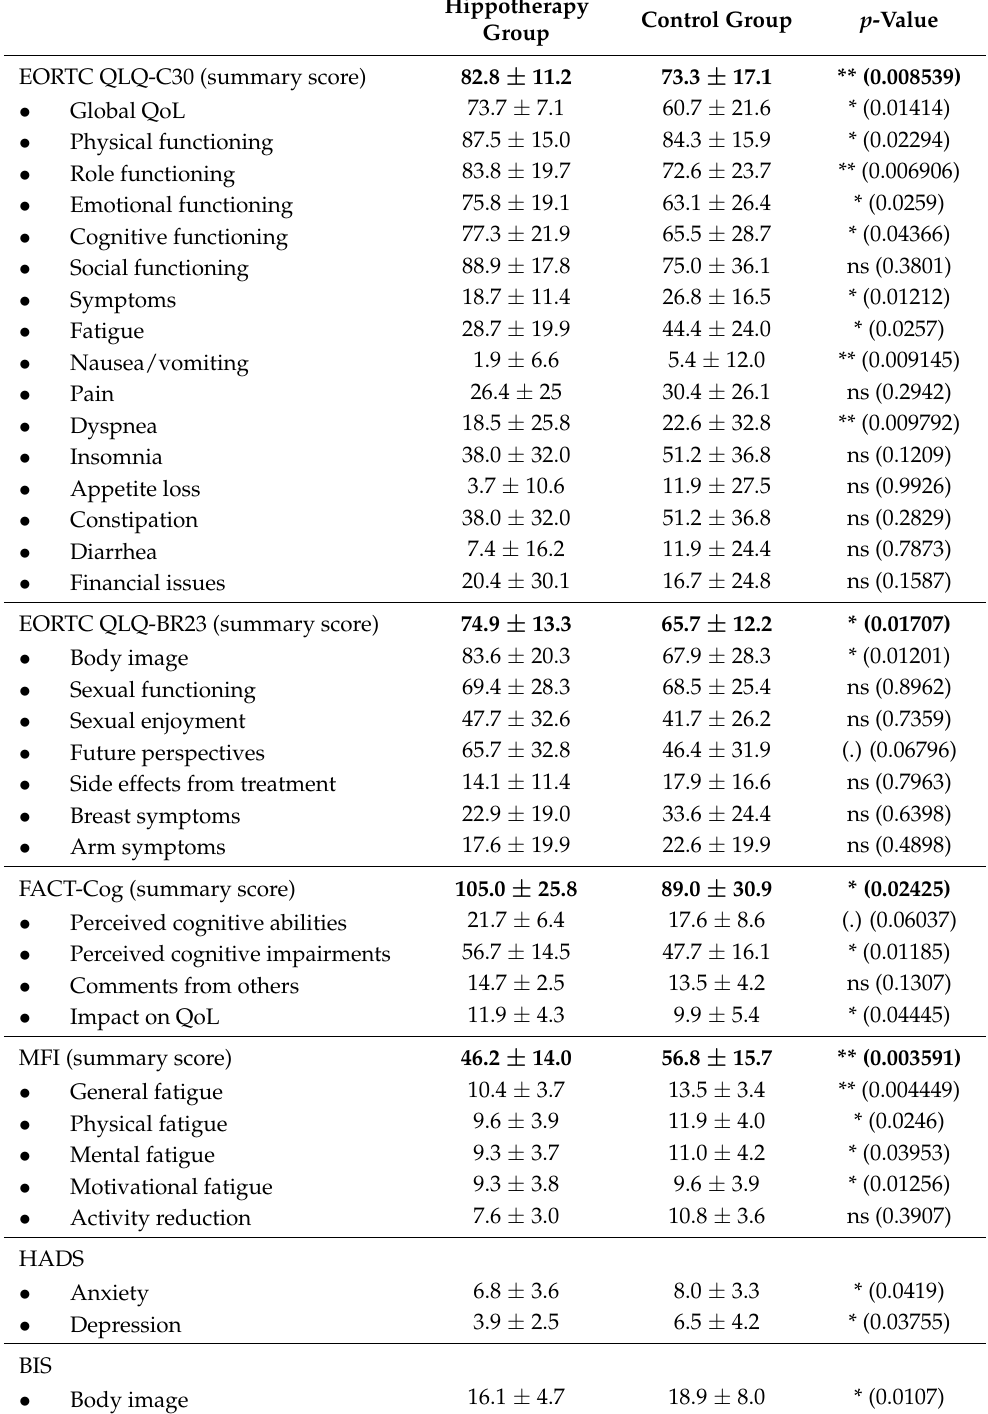
Table A2. Comparison of questionnaires’ summary scores and subsets obtained at baseline between the two groups at Q3. The total scores (summary scores) and item scores for each clinical test (QoL EORTC QLQ-C30 and QLQ-BR23; cognitive function FACT-Cog V3; fatigue assessment MFI-20; anxiety and depression assessment HADS; and body image BIS) are provided as means ± standard deviations. p -values correspond to unpaired two-sided Wilcoxon statistics. (ns) non-significant; (.) close to significance (between 0.08 and 0.05); (*) p < 0.05; (**) p < 0.01. Hippotherapy Control Group p -Value Group EORTC QLQ-C30 (summary score) 82.8 ± 11.2 73.3 ± 17.1 **